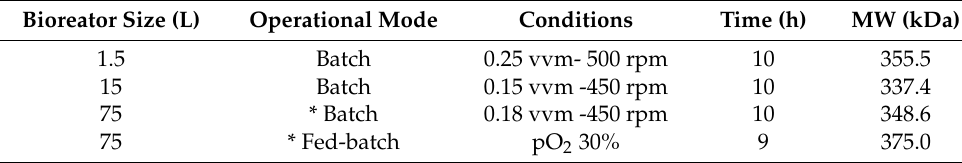
Table 4. Comparison of molecular weight—MW (kDa) of capsular PRP from H. influenzae